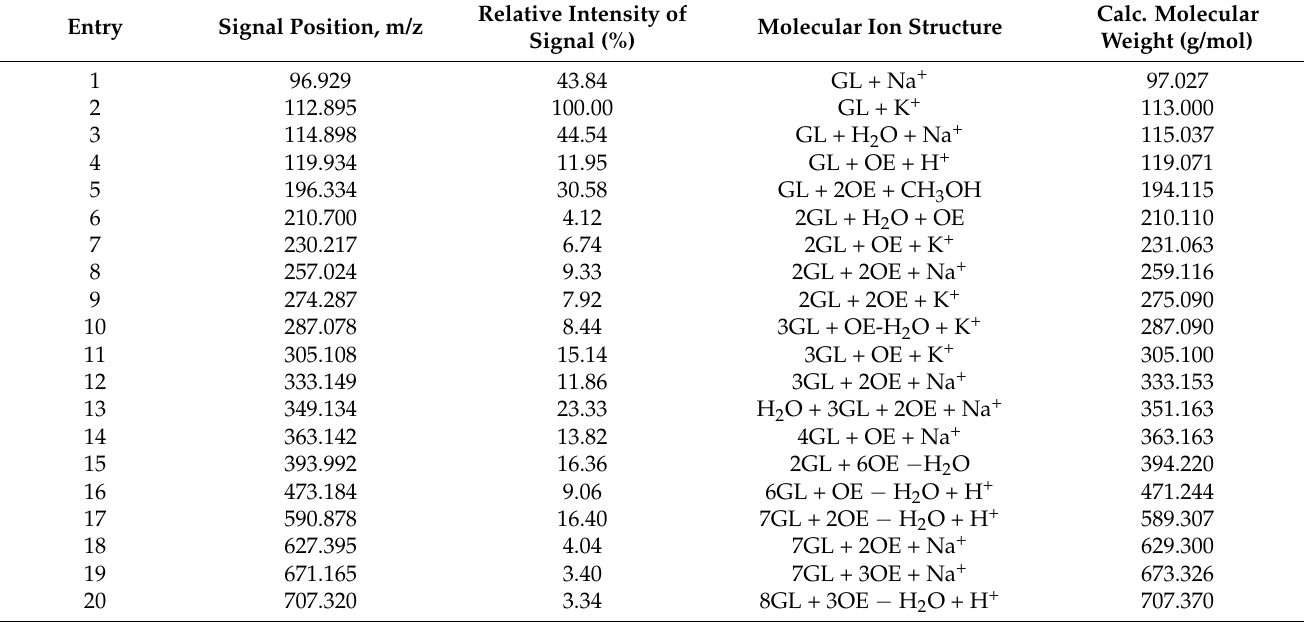
Table 1. Interpretation of MALDI-TOF spectrum of polyol (CS + GL) + EC.